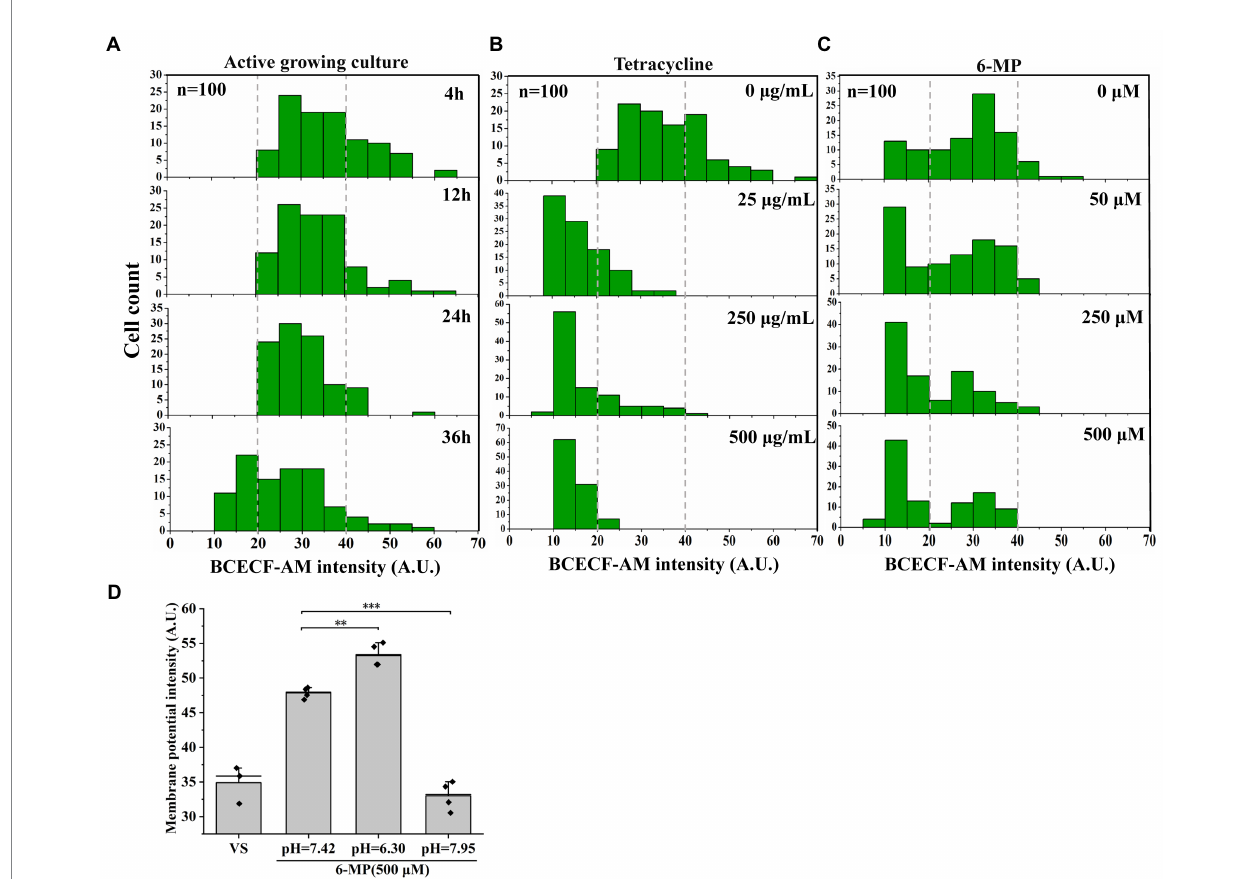
FIGURE 6 Membrane potential-mediated efflux pump depending on dissipating transmembrane proton pH gradient. BCECF-AM fluorescence intensity was assayed in active cell (A) , different concentrations of tetracycline treatment (B) ( n = 100 for each group) or 6-MP treatment (C) and the signal value were analyzed by ImageJ. After that, the membrane potential was determined after pH adjustment (D) ( n = 50 for each group). The bars indicated the mean of at least three independent experiments; standard deviation indicated STDEV. (* p value < 0.05; ** p value < 0.01; *** p value <